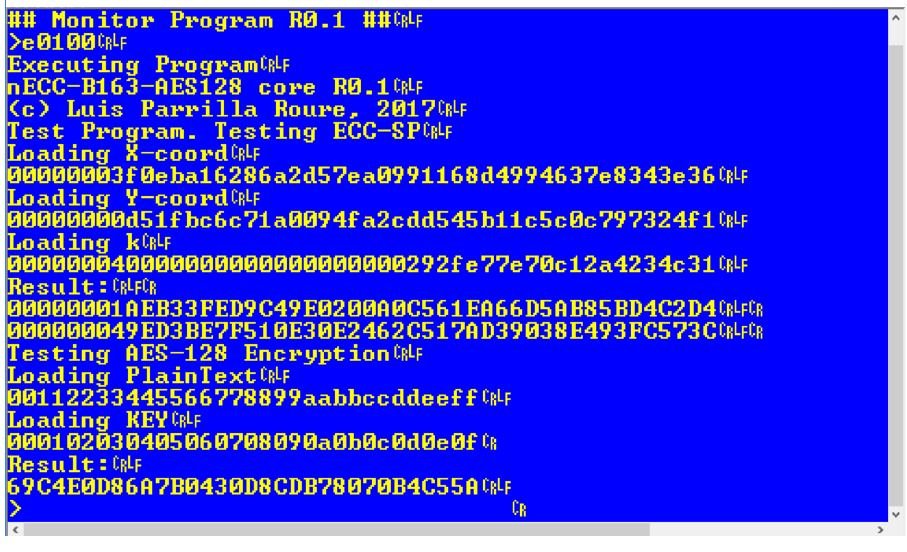
Figure 18. ECC163AES128 test program execution.